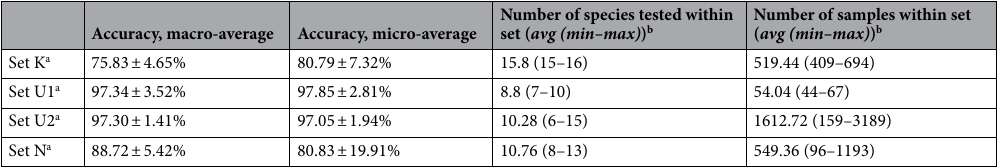
Table 1, Datafolds for more detailed sample information.